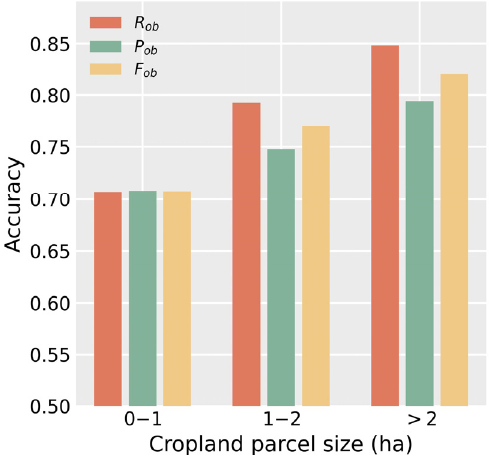
Figure 9. Stratified object-based evaluation results based on the size of cropland parcels.